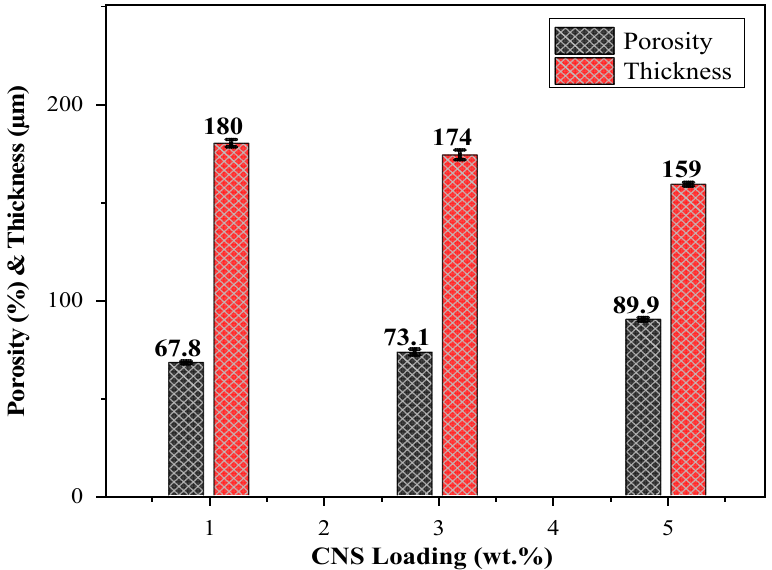
Figure 6. The effect of CNS loading in casting solution on the porosity and thickness of the composites’ membrane.